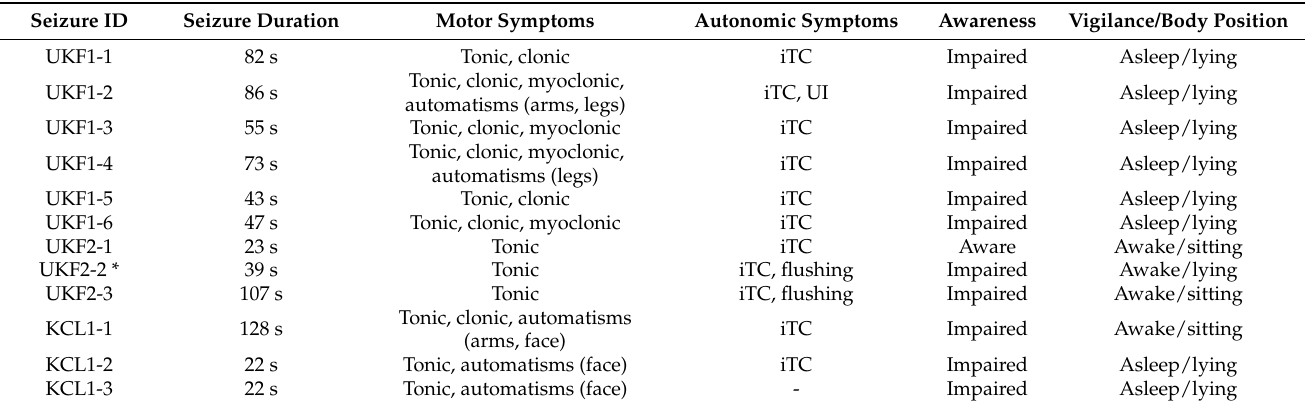
Table A1. Seizures recorded for the three participants used in the intra-subject evaluation. iTC: ictal tachycardia; UI: urinary incontinence.